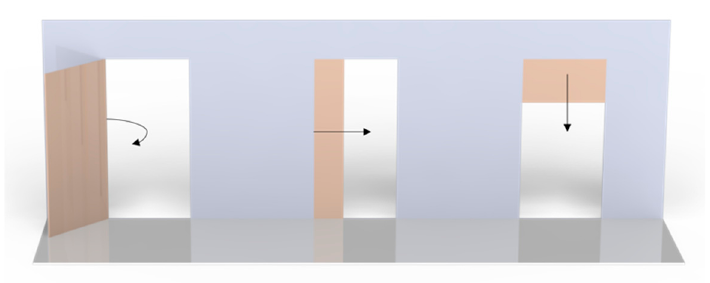
Figure 1. Types of door and their interaction with the user: normal force ( left ); horizontal force ( middle ); vertical force ( right ).